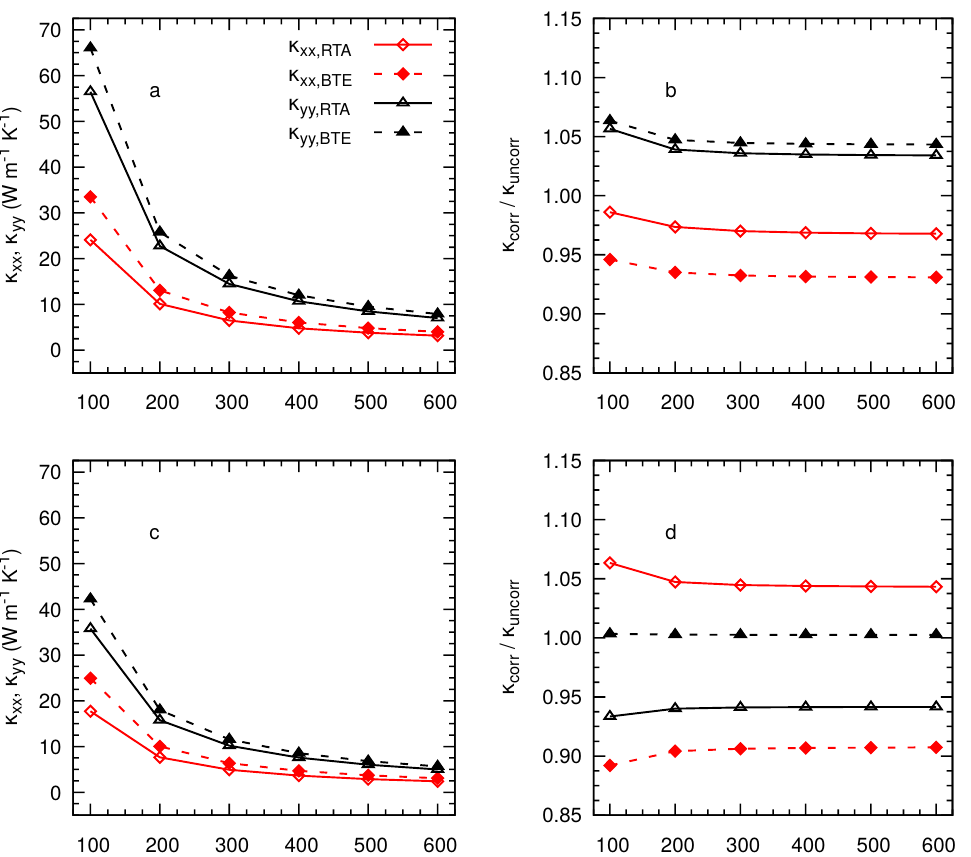
Figure 4. Corrected values of the thermal conductivity as a function of temperature after correcting the IFCs of the TiS 3 monolayer ( a ) and bilayer ( b ). Ratios of the corrected thermal conductivity with respect to their uncorrected values for the monolayer ( c ) and bilayer ( d